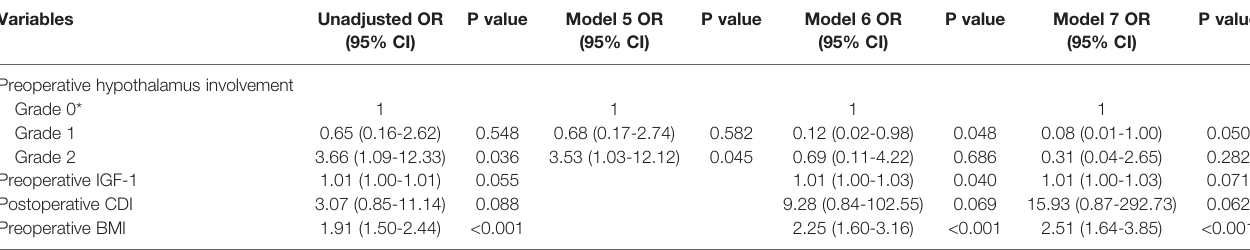
Model 5: age at diagnosis, gender, follow-up time, preoperative hypothalamus involvement. Model 6: Model 5 + preoperative IGF-1, postoperative CDI, preoperative BMI. Model 7: Model 6 + pathologic subtype, radiotherapy.